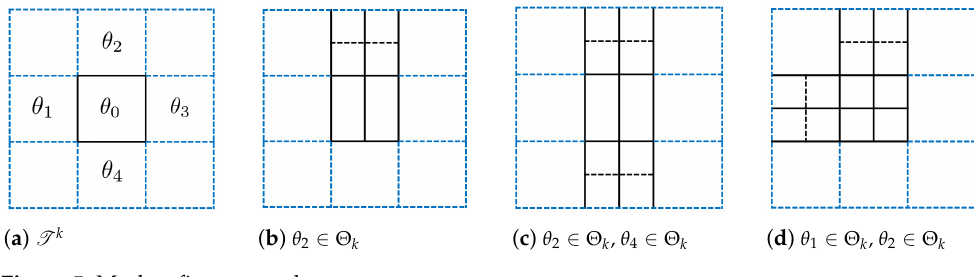
Figure 5. Mesh-refinement